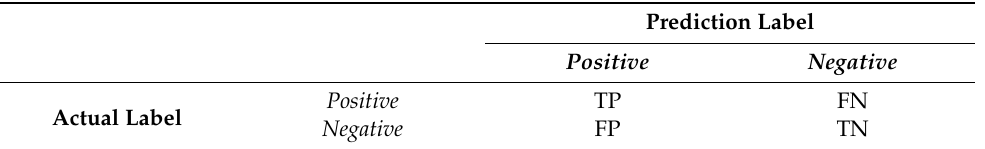
Table 3. Confusion matrix for two classes. TP: true positive; FP: false positive; FN: false negative; TN: true